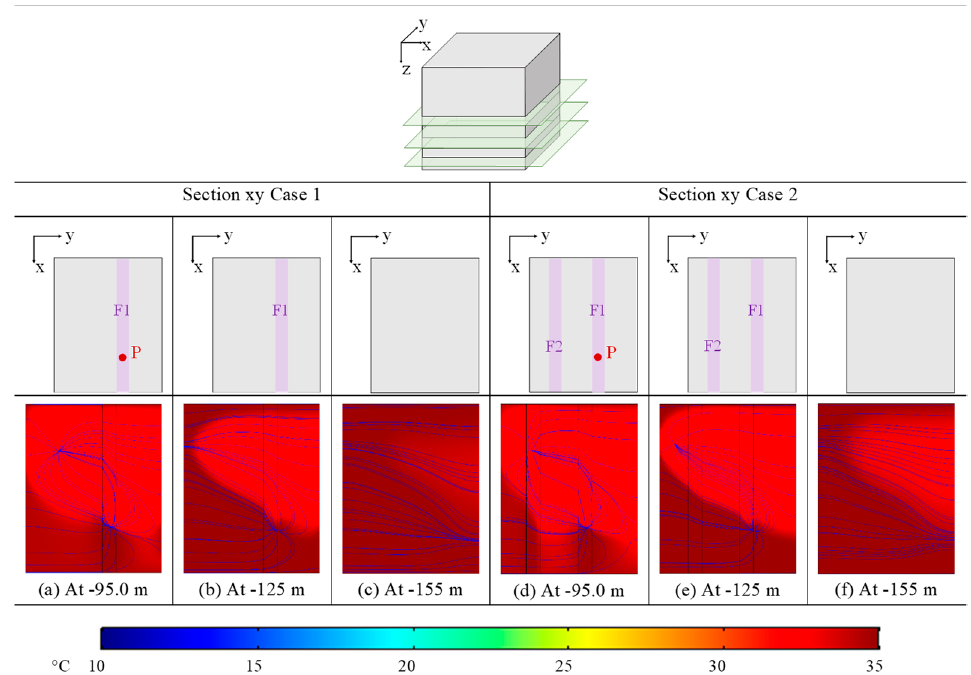
Figure 12. Temperature field at different depths, for Case 1 (single fault) and Case 2 (two faults).